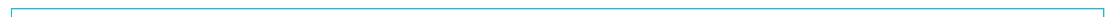
Figure 1: Conditions of innovation in digital health . This graph describes the conditions for innovation in digital health, for both licensed and non-licensed products and applications. Along the continuum from data generation to health impact, several conditions need to be fulfilled for digital health applications to have a tangible effect on individual and public health. To begin with, sufficient amounts of health data about in- dividuals, as well as other types of data helpful to the detection, treatment and monitoring of health conditions in peoples and populations, need to be accessible to developers. Secondly, digital health products need to comply with data protection and privacy requirements in the countries in which they operate. Third, accountability mechanisms should be in place to trace responsibility for data uses and their conse- quences on individuals, families and communities. Accountability also ensures transparent communication of health relevant information to da- ta subjects. Fourth, solid evidence of safety and efficacy should back medical claims of digital health products. More rigidly enforced eviden- tiary standards – including cost-effectiveness requirements – will foreseeably apply to digital health products seeking license from national regulatory agencies (such as the FDA or EMA). Yet, also non-licensed products can and should have sufficient evidentiary bases. Only the ful- filment of all such conditions creates trust in developers and regulators of digital health products and is conducive to fair benefit sharing of digi- tal health